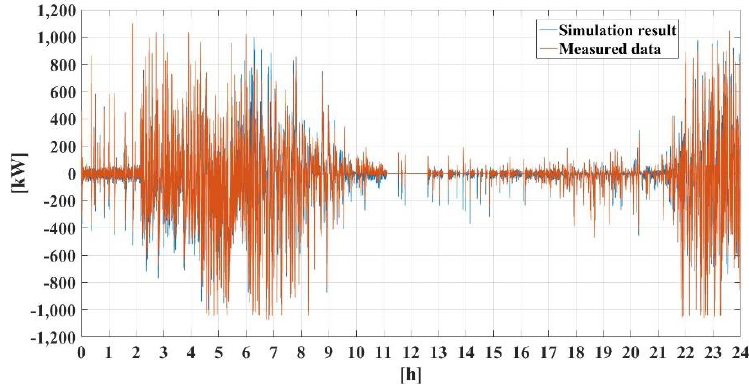
Figure 22. Field test and simulation results: output powers of ESS.